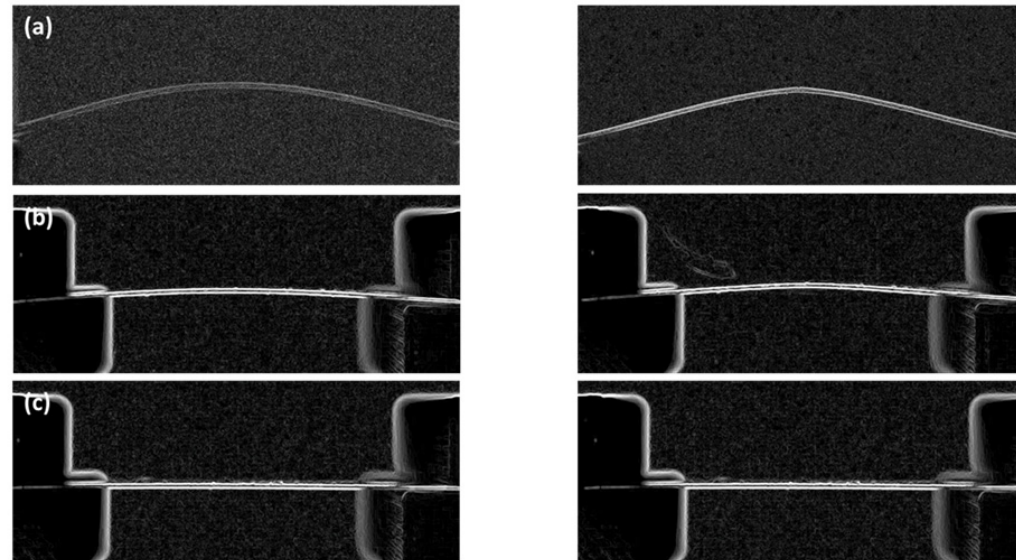
Figure 8. Curvature comparison image of polymer samples before (left) and after (right) laser scanning after image processing. ( a ) Radius of curvature 42 mm by F-theta lens, ( b ) radius of curvature 147 mm by F-theta lens, ( c ) radius of curvature 769 mm by F-theta lens .